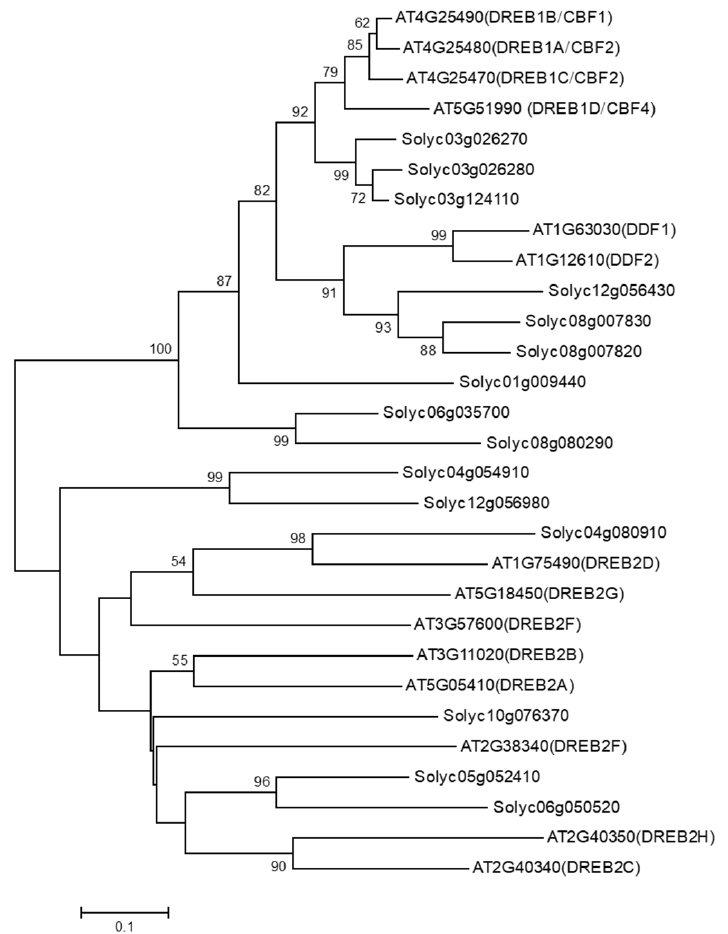
Figure 1. Phylogenetic analysis of Arabidopsis proteins belonging to the DREB-A1 and DREB-A2 groups and their closest orthologs in tomato plants.